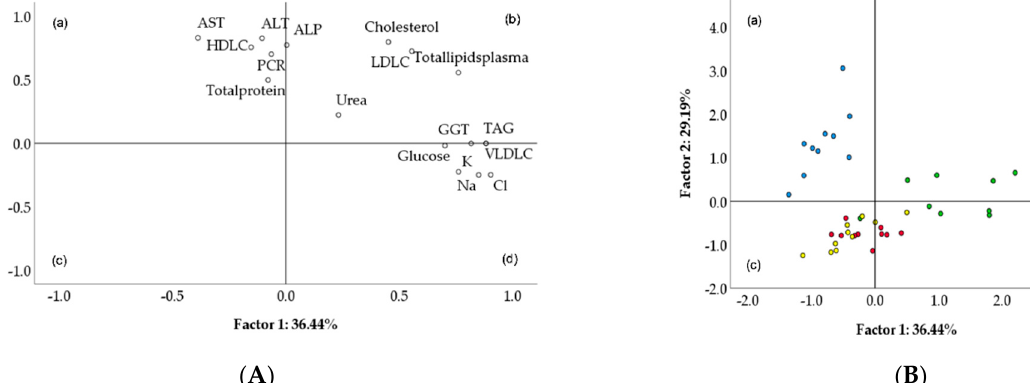
Figure 1. Loading plot of the first and second principal factors of the pooled data ( A ) and component score vectors ( B ) using plasma metabolites from broilers fed with different diets: Control, corn- soybean based-diet; UL, based-diet plus 15% U. lactuca ; ULR, UL diet with 0.005% commercial CAZyme (Rovabio ® Excel AP); ULL, UL diet with 0.01% recombinant ulvan lyase; (a)–(d) represent the quadrants of two dimensional distribution of parameters.